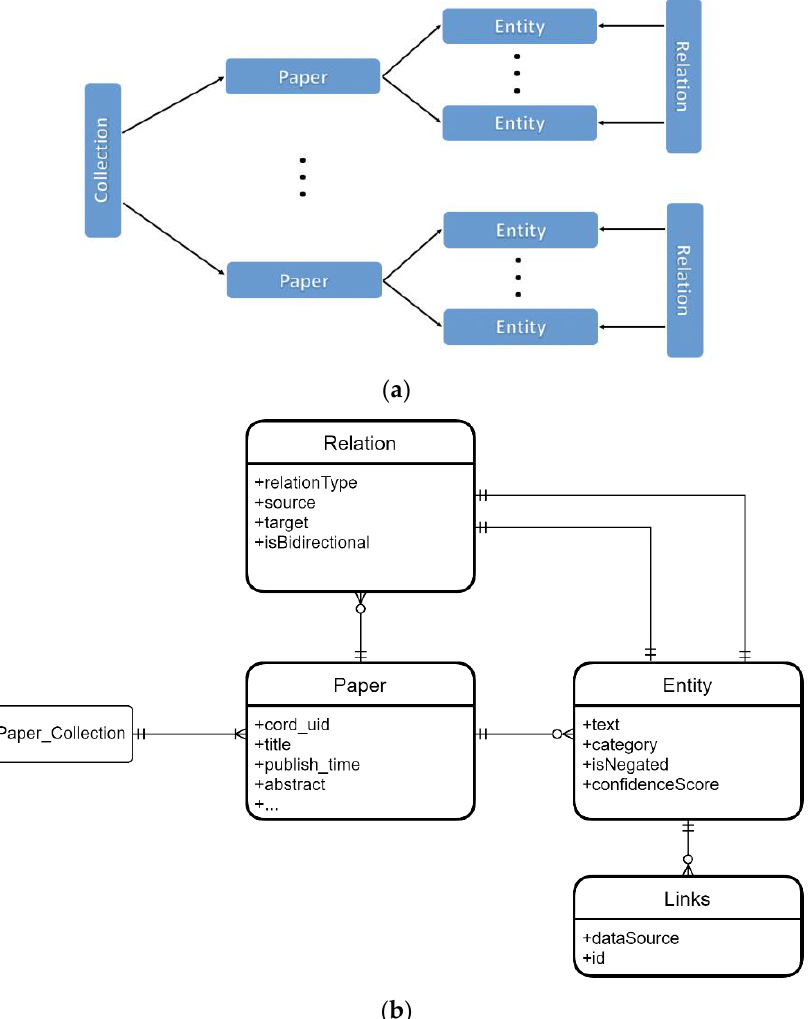
Figure 2. ( a ) The overall hierarchical structure of entity/relation metadata for each paper abstract from text collection. Each paper from a collection has a number of entities and corresponding relations between them within the scope of one paper/abstract. ( b ) Entity diagram corresponding to Cosmos DB document store representing papers/entities/relations. Because we do not have relations between entities in different papers, we can store each paper metadata as one separate JSON document, together with entities and relations between